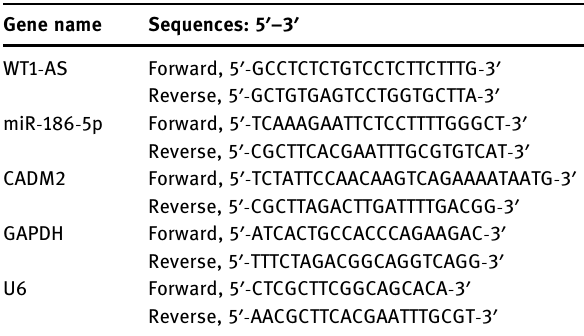
Table 1: Primer sequences for PCR Gene name Sequences: 5 ′– 3